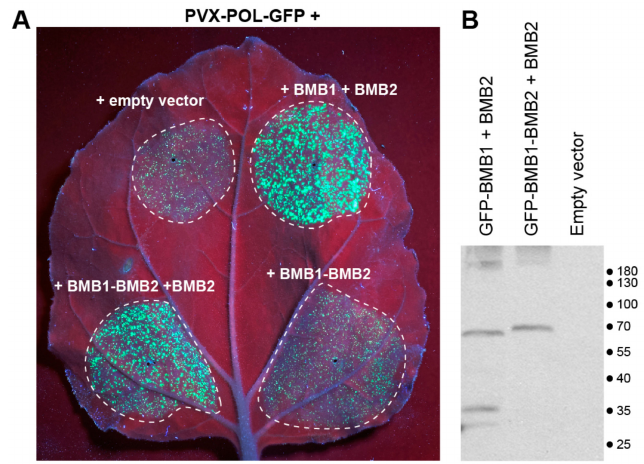
Figure 9. Analysis of properties of the BMB1-BMB2 fusion protein. ( A ). Analysis of functional competence of BMB1-BMB2 in PVX-POL-GFP complementation test. Complementation of cell-to-cell movement of PVX-POL-GFP by combinations of BMB1 with BMB2 (positive control), BMB1-BMB2, BMB1-BMB2 + BMB2 and empty vector (negative control) is shown. The leaf was imaged under UV light at 5 d.p.a. Dashed lines encircle infiltrated areas. ( B ). Western blot analysis of GFP-BMB1-BMB2 with GFP-specific antibodies in N. benthamiana leaves agroinfiltrated for coexpression of GFP-BMB1- BMB2 and BMB2. In controls, leaves were agroinfiltrated for expression of either GFP-BMB1 and BMB2, or an empty vector. Positions of molecular weight markers (in kDa) are shown on the